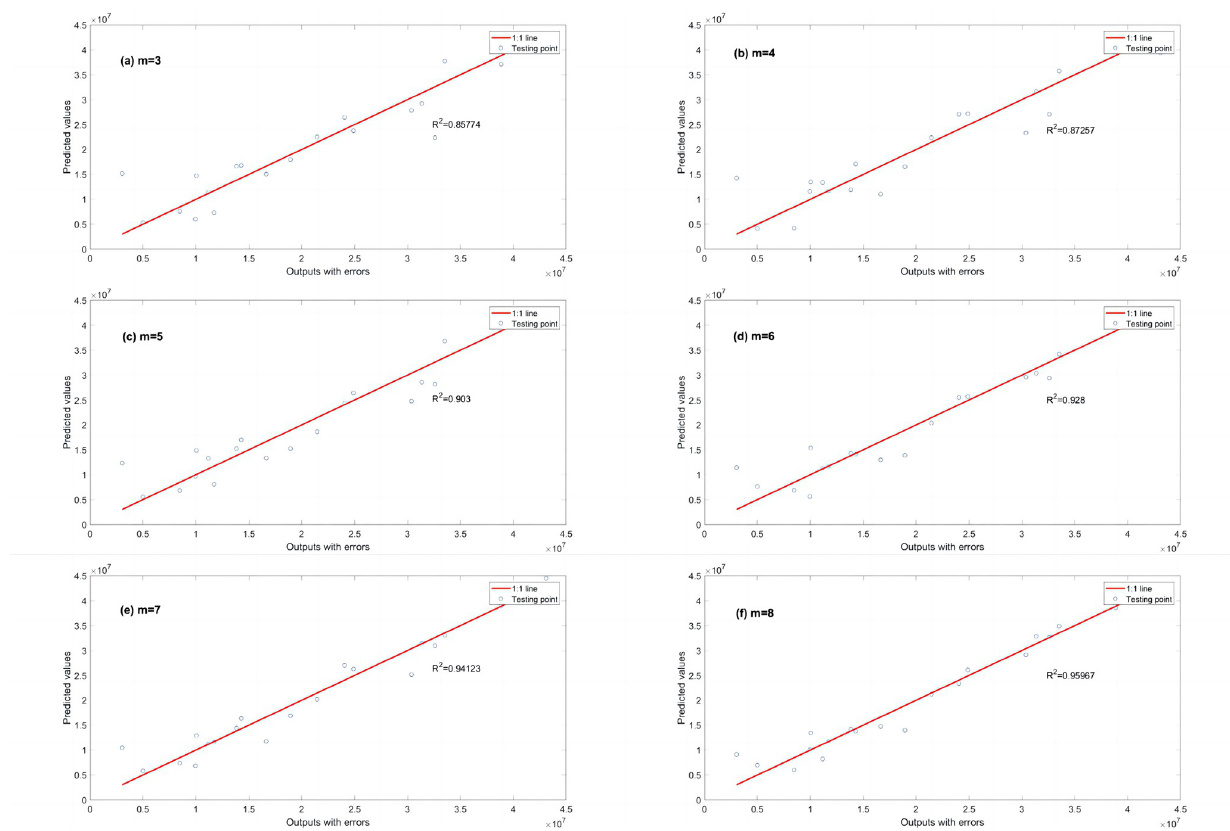
Fig 12. R 2 calculated by EPR with L1RM in dataset 3. (a) m = 3, (b) m = 4, (c) m = 5, (d) m = 6, (e) m = 7 and (f) m =